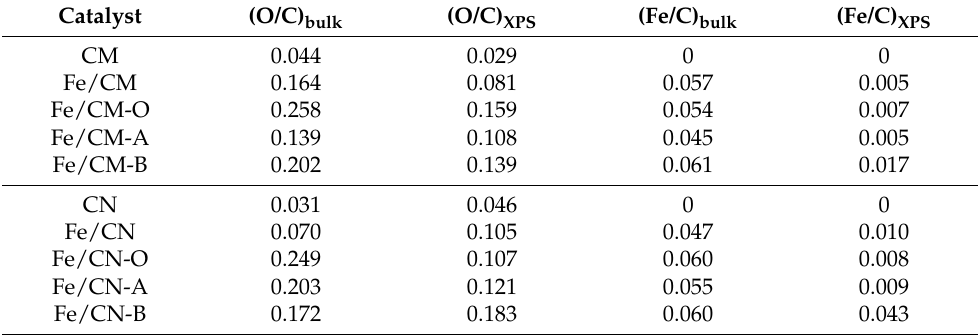
Table 5. Surface and bulk O/C and Fe/C atomic ratios on Fe/AC- f , and raw AC